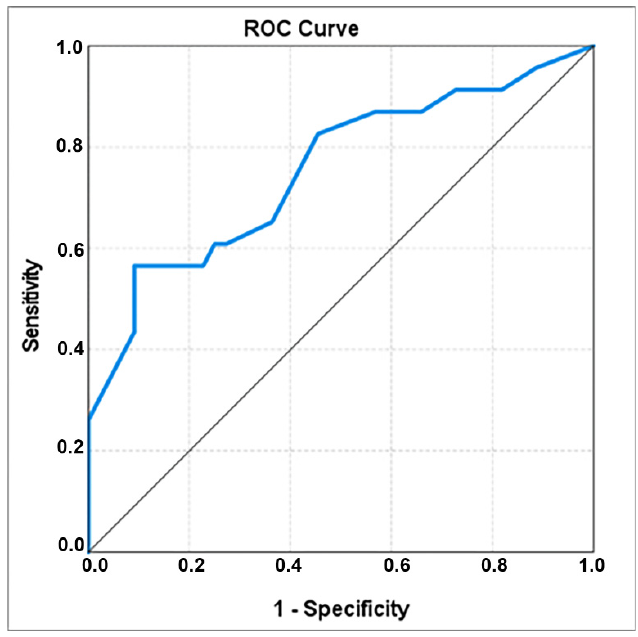
Figure 3. ROC curve for gestational age at admission.